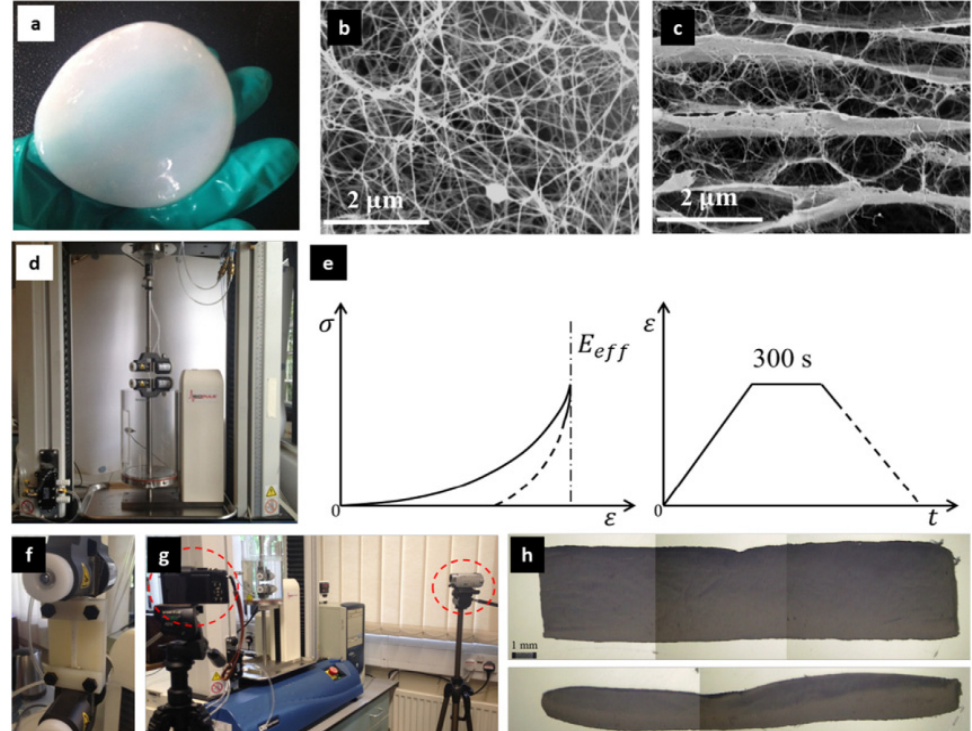
Figure 3. BNC hydrogel ( a ), random distribution of BNC nanofibres in fibrous layer ( b ), multi-layer network with a few crosslinks ( c ), Instron (3366) with a bath-system (BioPuls) for uniaxial in aqua tension ( d ), schematic of getting effective elastic modulus of bulk hydrogel ( e ), custom-made attachment to fix stretched specimens to prevent elastic recovery ( f ), digital cameras (two) to evaluate changes in the geometry of specimens ( g ), and optical microscopical images of freeze-dried specimens to measure total volume ( h ). Reproduced with permission from [71]. Copyright 2017 Elsevier.